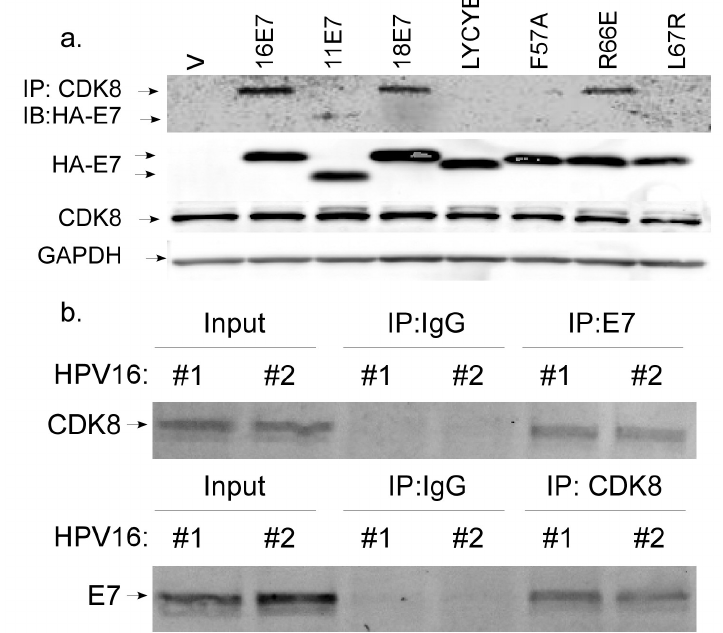
Figure 5. Interaction of E7 and CDK8. ( a ) Expression vectors encoding HA-tagged E7s from human papillomavirus (HPV) types 16, 11, 18, and the indicated mutants (16E7) were transfected into U2OS cells. Thirty-six hours later, total cell lysates were harvested. CDK8-containing complexes were immunoprecipitated with anti-CDK8 antibodies. Anti-HA antibody was used to detect HA-E7 by Western blotting (IB) of the immunoprecipitates (top panel). Immunoblot of total HA-E7, CDK8, and GAPDH present in the transfected U2OS cell lysates (middle panels and bottom panel) are also shown. ( b ) Immunoprecipitation was performed using total lysates from HPV16 + cells from two HFK donors with either anti-E7 antibodies (top panel), anti-CDK8 antibodies (bottom panel) or IgG (negative control). CDK8 was detected in both the anti-E7 immunoprecipitate and in the input by immunoblotting (top panel). E7 was detected in both the anti-CDK8 immunoprecipitate and in the input by immunoblotting (bottom panel).